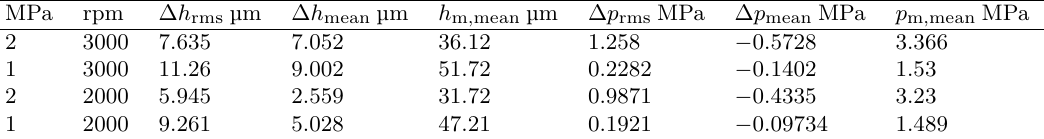
Table 5: Temperature and power loss comparisons for simulations and measurements. The lubricant tempera- ture is set to the mean value of inlet and outlet temperature, i.e., T lub = T in+ T out difference is presented as a relative error in %, i.e., ∆ P rel . The differences in the temperature measure- ment points are given as absolute RMS values ∆ T rms , and also as mean values ∆ T mean . For reference the mean values of the temperature measurements T m,mean are given as well. MPa rpm T in ◦ C T out ◦ C ∆ P rel % P m W ∆ T rms ◦ C ∆ T mean ◦ C T m, mean ◦ C 2 3000 50 . 073 64 . 116 − 25 . 8 3000 50 . 221 Table 6: Film and pressure comparisons for simulations and measurements. The differences in the measurement points are given as absolute RMS values, and also as mean values. For reference the mean values of the measurements are given as well. MPa rpm ∆ h rms µ m ∆ h mean µ m h m,mean µ m ∆ p rms MPa ∆ p mean MPa p m,mean MPa 2